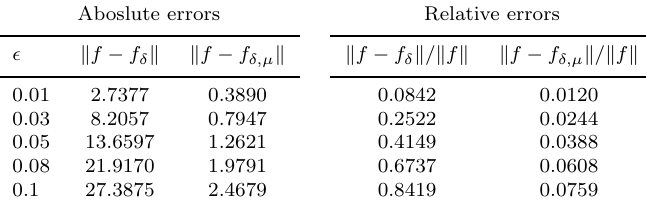
Table 5. Example 5: Errors assuming α 2 = 0 . 4 , β = (1 , − 0 . 5 , − 0 . 5) ,ν = 0 . 997 ,t 0 = 1 , p =